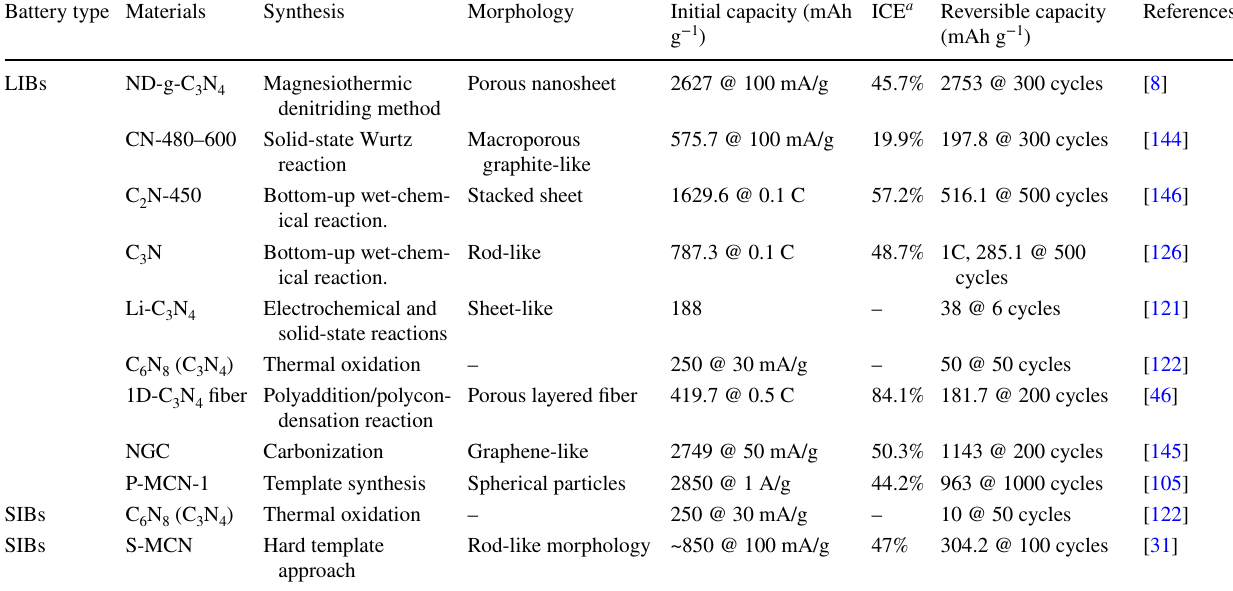
Table 2 Pure and doped carbon nitrides for LIBs and SIBs